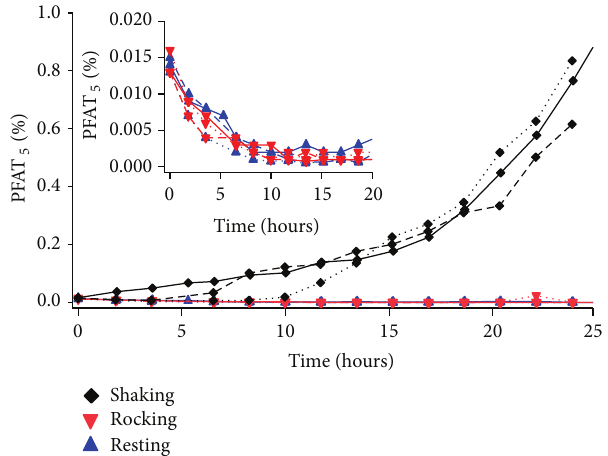
Figure 2: The effects of three different agitation levels on emulsion stability were evaluated in triplicate over a 24-hour period by measuring the changes PFAT 5 at rest (upward triangle), gently rocked (downward triangle), and vigorously shaken (diamond). The inset focuses on the rest and gentle rock conditions where PFAT 5 is observed to decrease significantly especially at early